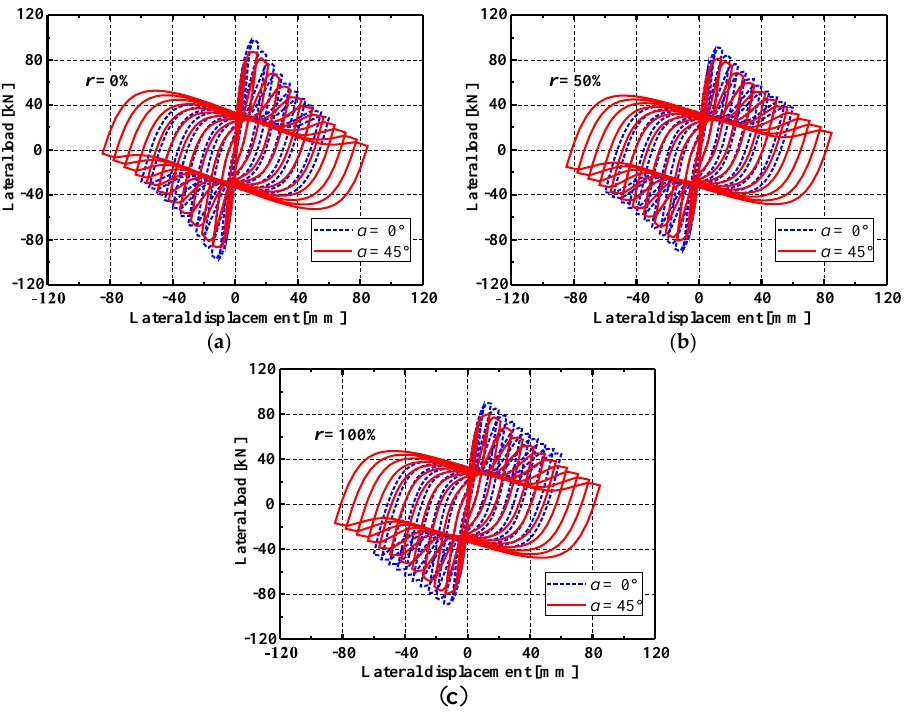
Figure 15. Effect of bi-directional loading on hysteresis loops of RRC columns ( n = 0.3). ( a ) r = 0%, ( b ) r = 50%, and ( c ) r = 100%.